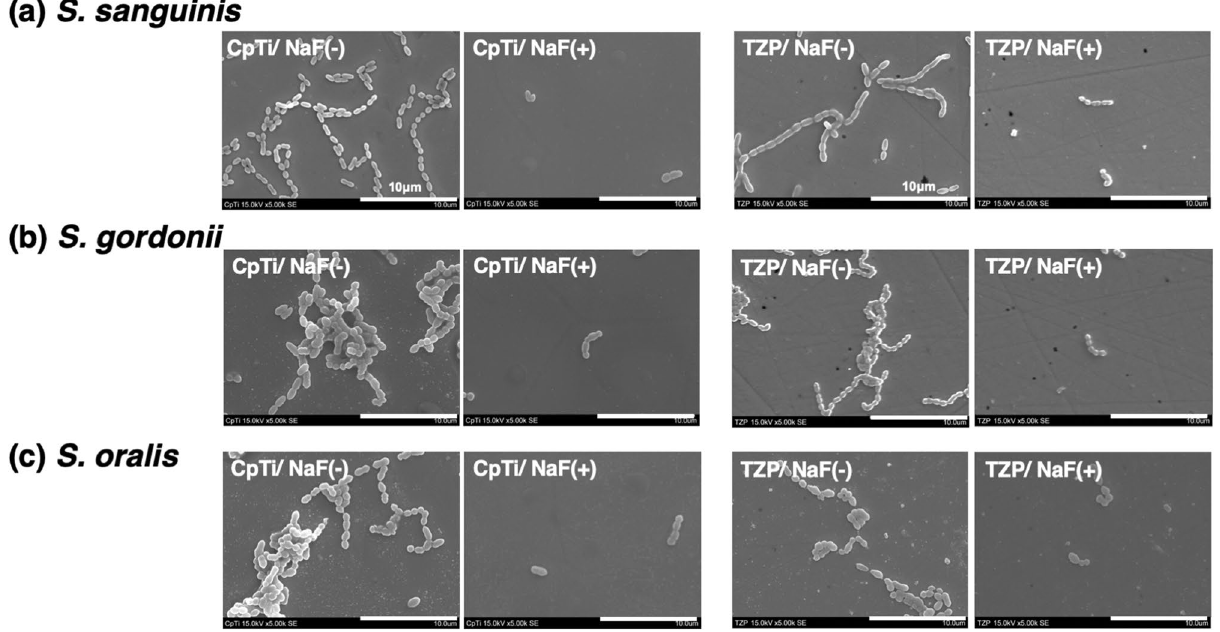
Figure 5. SEM images of the streptococci. The SEM images of the bacteria on the CpTi and TZP surfaces are shown. ( a , b , c ) In both CpTi and TZP, the streptococcal adherence on NaF (+) surfaces was lower than that on NaF (−)